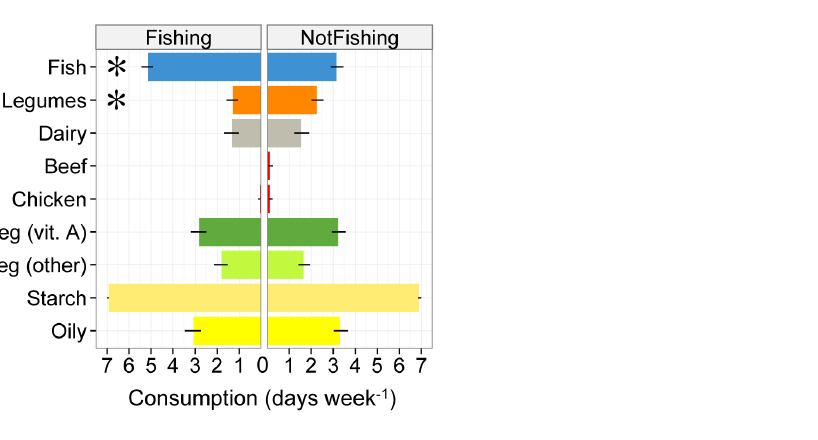
Figure 3. Diets of Kenyan coastal households with and without fishing as the primary livelihood. Diets are described in terms of weekly consumption (number of days consumed per week) of seven major food groups. Asterisks indicate significant differences in post-hoc comparisons after controlling for multiple tests (n 5 53 fishing households, n 5 58 non-fishing households).